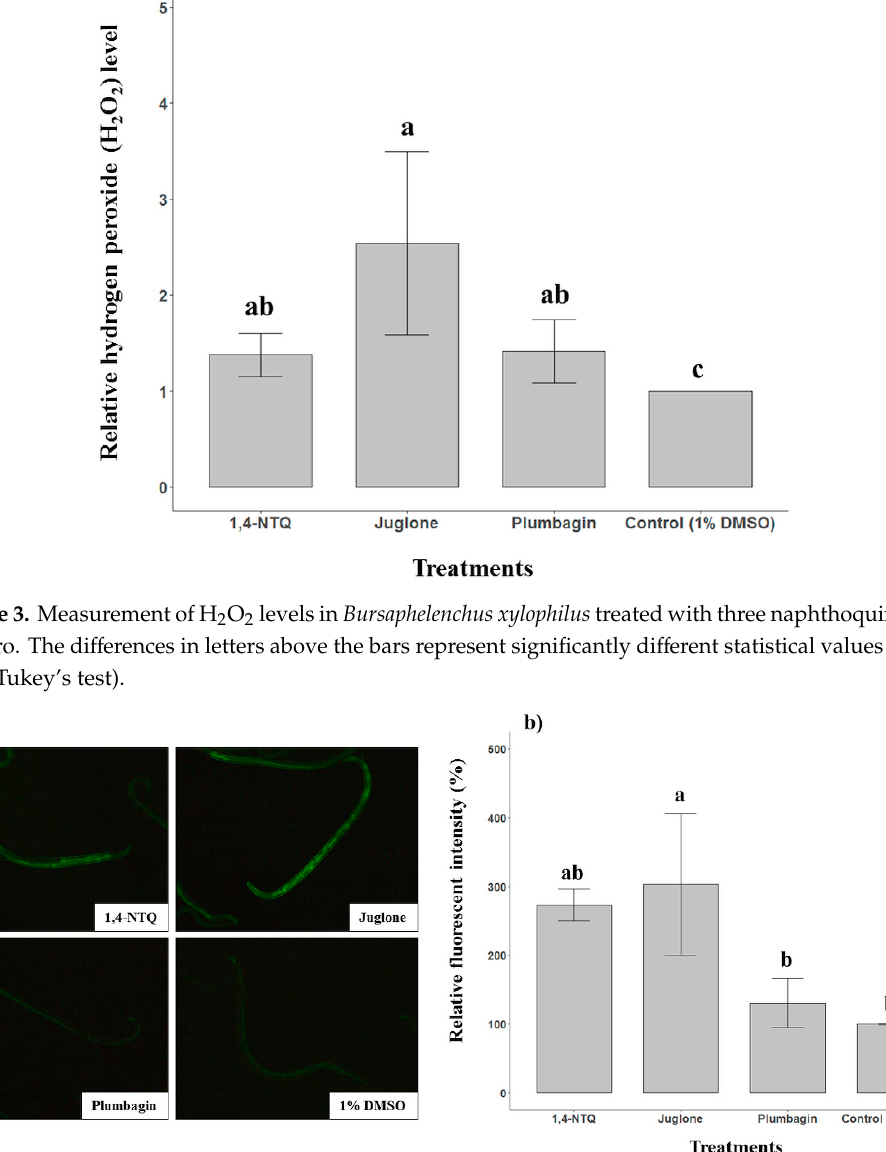
Figure 4. Three naphthoquinones stimulate the reactive oxygen species (ROS) production in Bursaphelenchus xylophilus in vitro. ( a ) B. xylophilus was incubated with 50 ppm concentrations of 1,4-NTQ, juglone, and plumbagin and a 1% DMSO solution as the control for 3 h, and then treated with 12.5 μ M 2 ′ ,7 ′‐ dichlorofluorescein diacetate for 30 min and photographed by fluorescence microscopy. ( b ) The graph represents relative fluorescent intensity of 2 ′ ,7 ′‐ dichlorofluorescein generated by the three naphthoquinones compared with that by 1% DMSO. Statistical differences in the means are indicated with different lower ‐ case letters. Bars represent standard deviation.